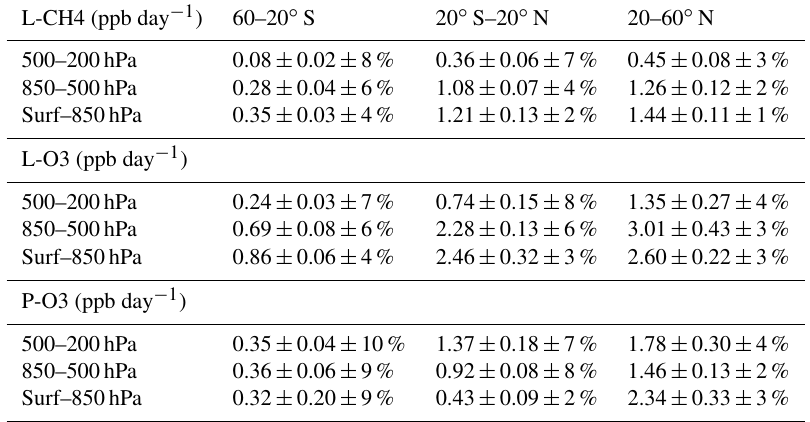
Table 2. Representativeness of reactivities (L-CH4, L-O3, and P-O3 – all in ppb day − 1 ) averaged over three latitude and three pressure domains over the central Pacific (155–233 ◦ E). The first standard deviation (ppb day − 1 ) is over the different longitudinal transects on mid- August; and the second (%) is for the average across longitudes sampled over 31 days of August.